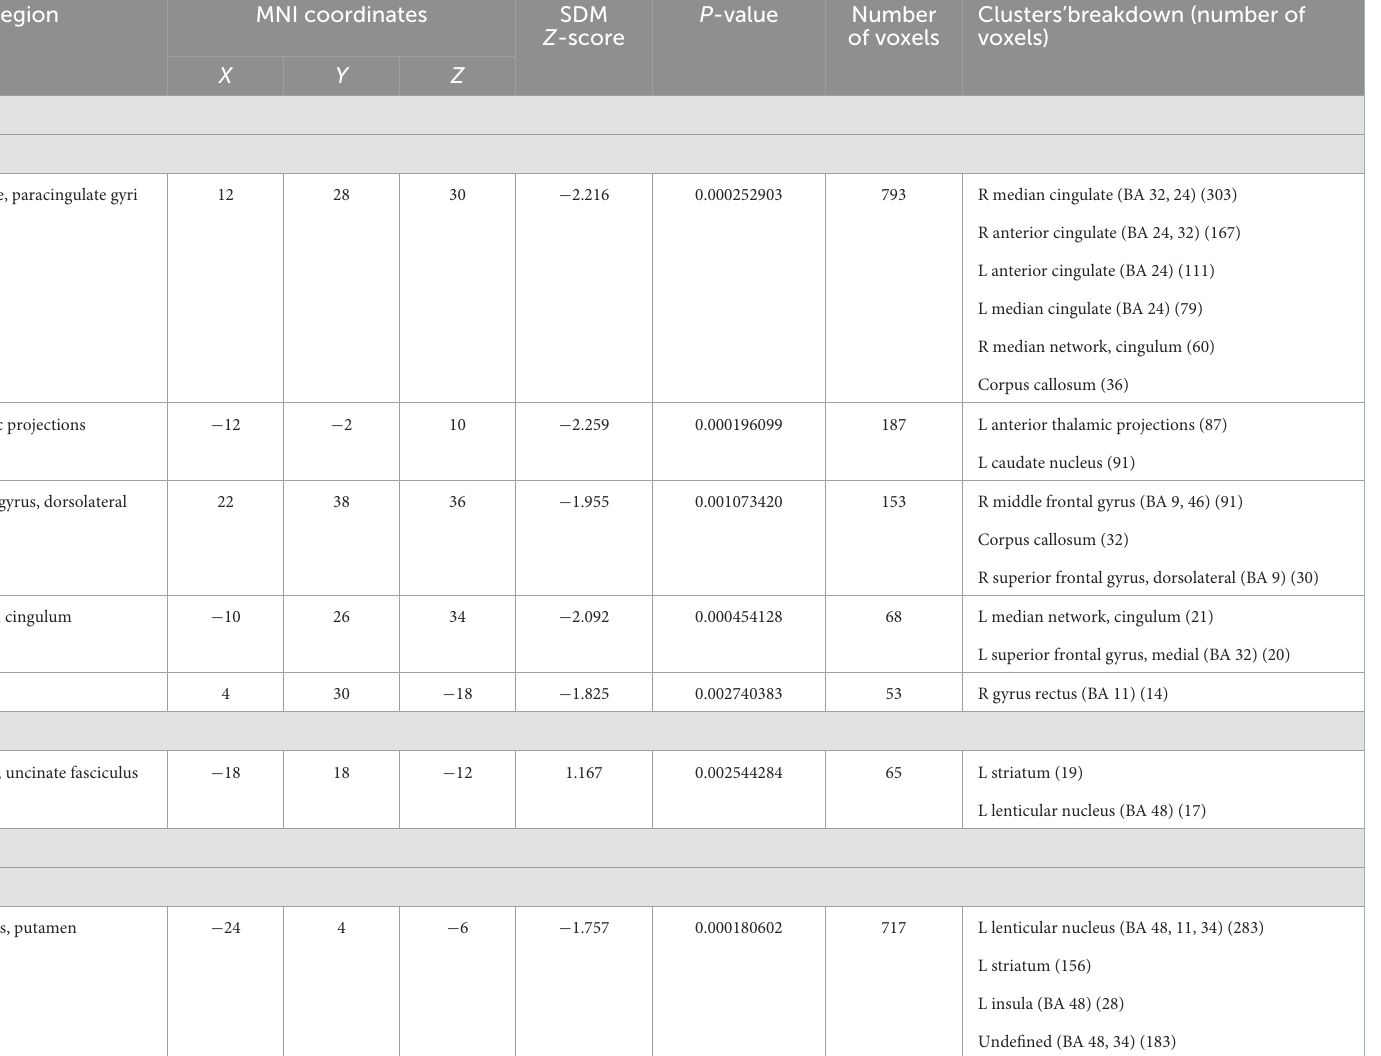
TABLE 4 Subgroup analysis results for voxel-based morphometry and fMRI studies in ADHD (adults group). Contrast Anatomical region MNI coordinates SDM